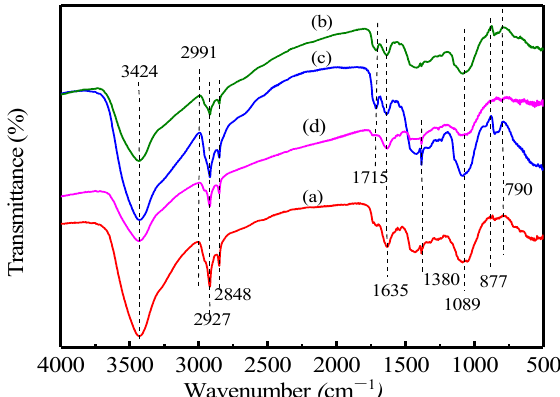
Figure 5. FTIR of the PPG-nZVI beads. ( a ) is the result of the PPG-nZVI beads before adsorption. ( b ), ( c ), and ( d ) is the result of the PPG-nZVI beads after adsorption of Pb 2+ , Cu 2+ , and Zn 2+ respectively. The initial concentration of each heavy metal ion is 50 mg·L − 1 ; the dosage of PPG-nZVI beads, 5.0 g·L − 1 ; pH, 6.0 and temperature, 25 °C.